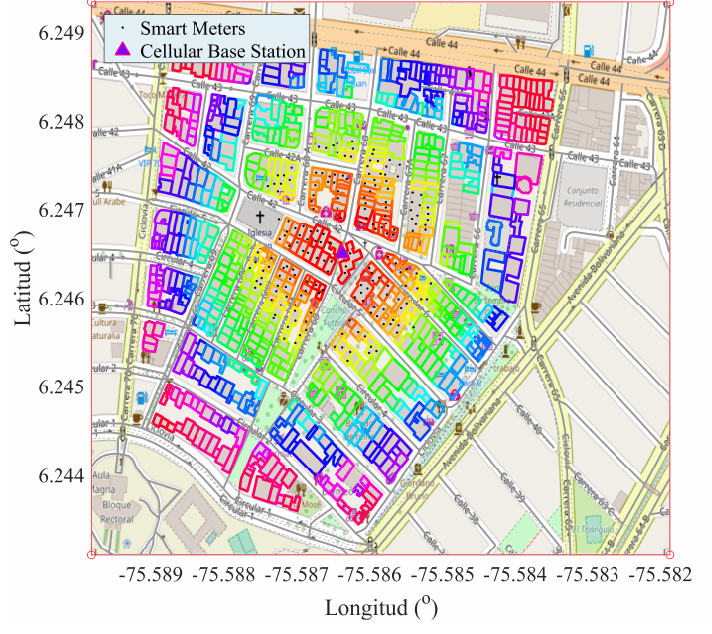
Figure 3. Radial deployment of smart